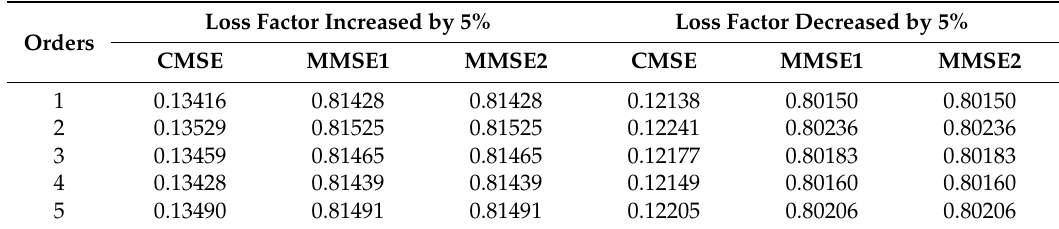
Table 3. Modal loss factors of composite plate corresponding to different loss factor of hard coating/10 − 3 .